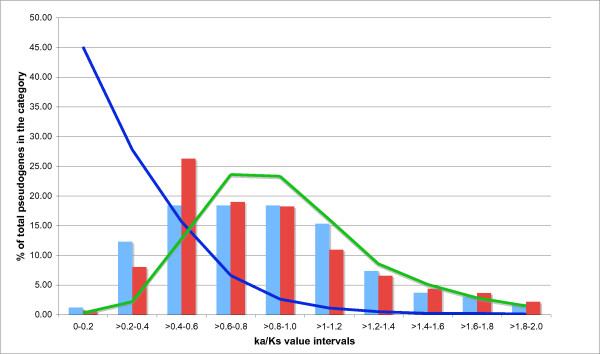
Distributions of Ka/Ks for TPADDs (blue bar), and TPANDDs (red bar). Also shown are: the distribution of Ka/Ks for simulated sequences that have randomly mutated without coding-sequence selection pressures (green curve; derived as described in Methods), and the Ka/Ks distribution for orthologous pairs of known protein-coding genes from rhesus monkey and human.